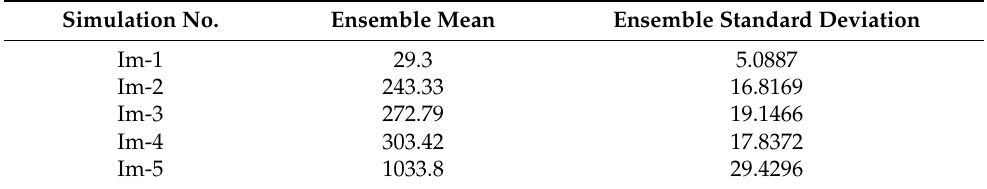
Table 7. The ensemble mean and standard deviation of concentration at the receptor grid (explicit